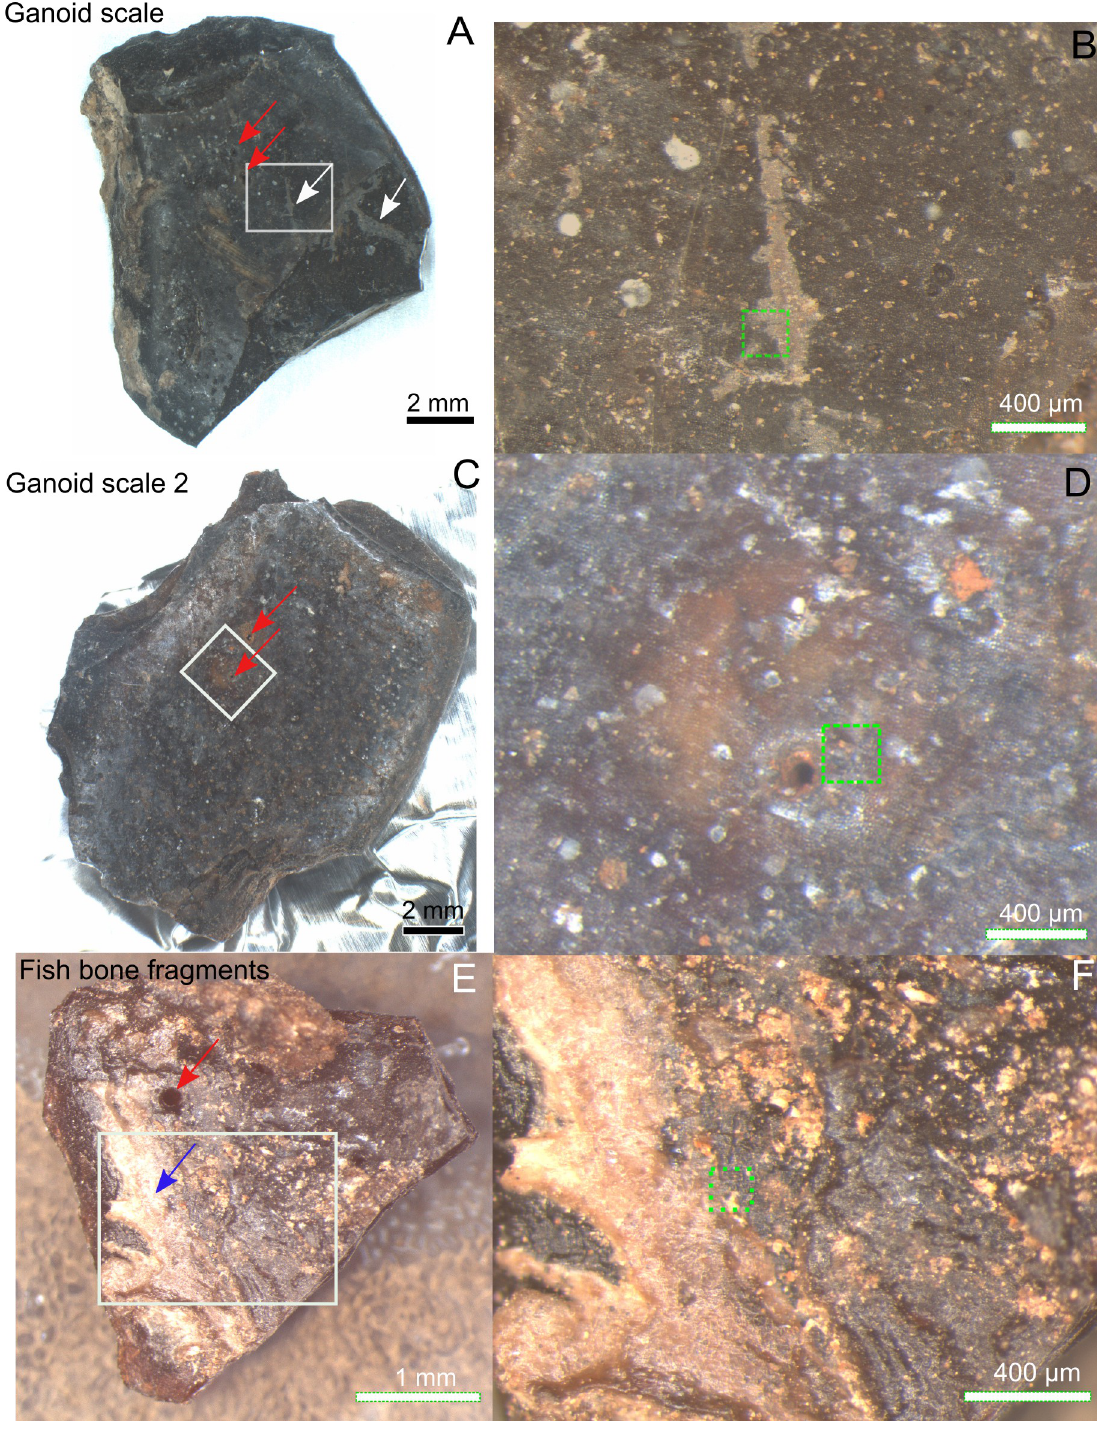
Fig 1. Messel fish Atractosteus ganoid scales and bones where porphyrins were detected. A) Ganoid scale 1 with gray-brown film. White arrows indicate presence of gray-brown film on parts of ganoid layer and exposed laminar bone. Red arrow shows aperture penetrating ganoid layer. B) Zoom-in of white box in A. C) Ganoid scale 2. Red arrows indicate presence of apertures in ganoid layer. D) Zoom-in of white box in C. E) Fish bone fragment. Red arrow indicates foramen in bone while blue arrow indicate area with whitish non- bony structure. F) Zoom-in of white box in E. Green dotted squares in B, D, F indicates precise area of ToF-SIMS analysis in Figs 2 and 3 and S3–S5.